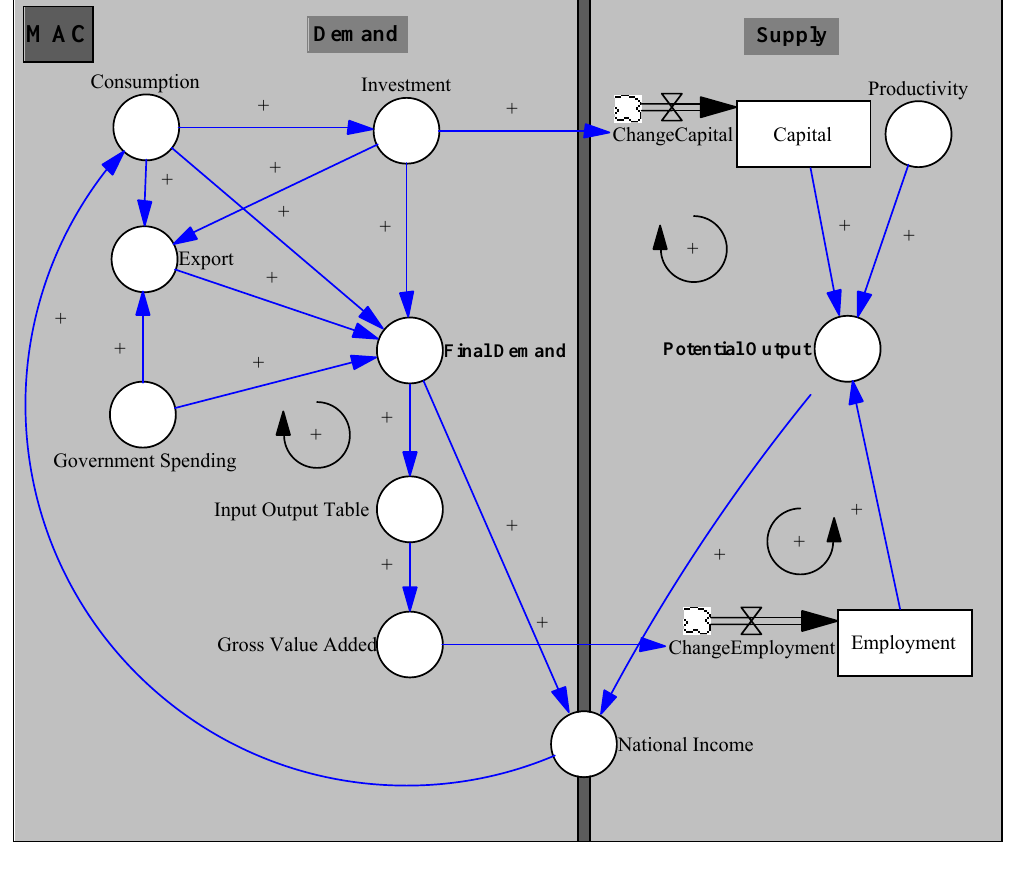
Figure 3. Demand and Supply Side in